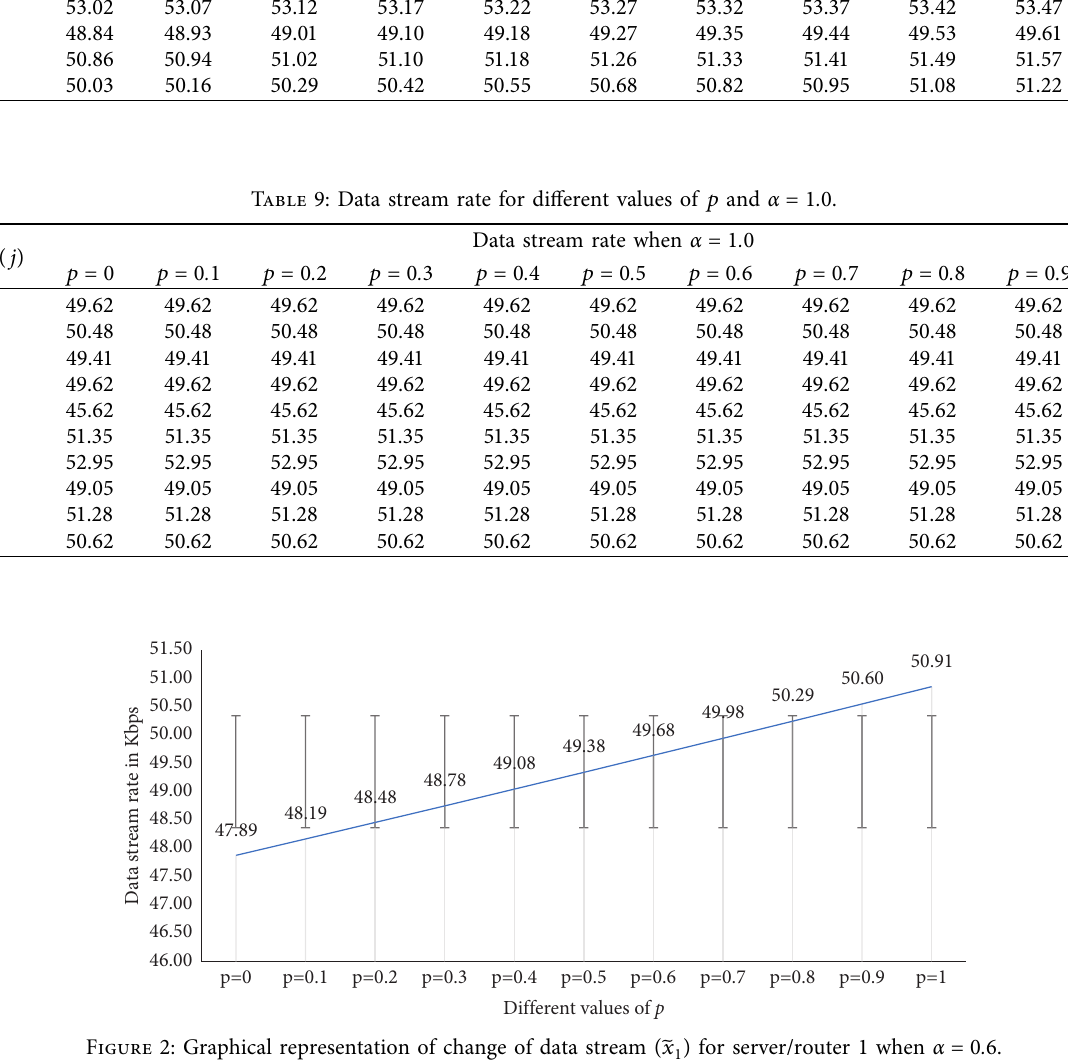
) for server/router 1 when α � 0 . 1